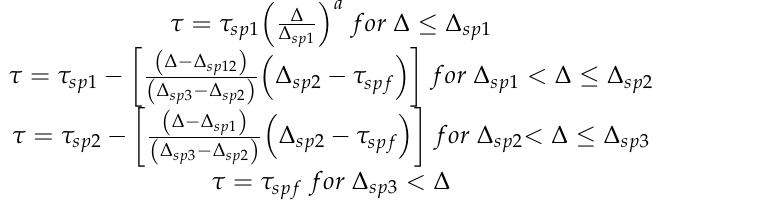
Figure 10. Dowel resistance mechanism.